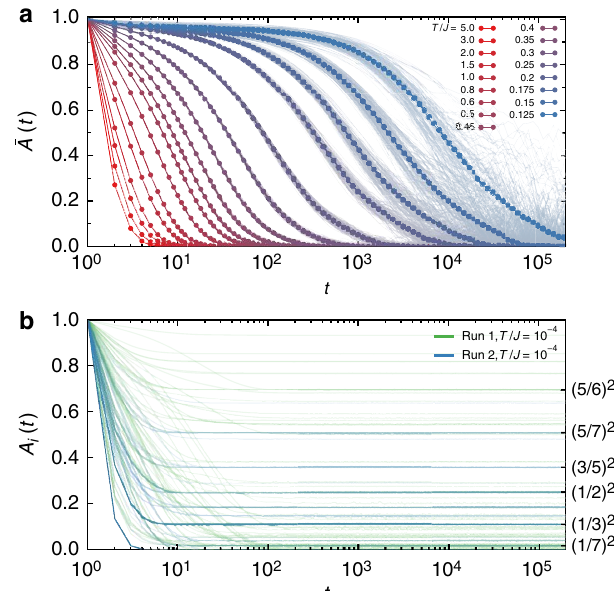
Figure 5 | Auto-correlation functions in extended spin ice. ( a ) Site- averaged auto-correlation function (cid:2) A t ð Þ at various temperatures for a system of 8 3 cubic cells. As we approach low temperatures, the relaxation time grows exponentially. Short-time dynamics is apparent in the initial decrease of (cid:2) A t ð Þ for t t 10 2 . The thin curves show a sample of the individual site-resolved A i ( t ) at each temperature, showing increasing levels of heterogeneity for T t T *. ( b ) Site-resolved auto-correlation functions A i ( t ) at the very low temperature T ¼ 10 (cid:3) 4 J . We show two distinct annealed runs of a system of 8 3 cubic cells. Aside from essentially frozen spins with A i ( t ) ¼ 1, one finds many spins that relax over time scales of 10 1 or 10 2 sweeps. At long times the auto-correlation functions reach constant values A i ( N ) that are clustered about the squares of simple, rational numbers (see text). NATURE COMMUNICATIONS|7:12234|DOI: